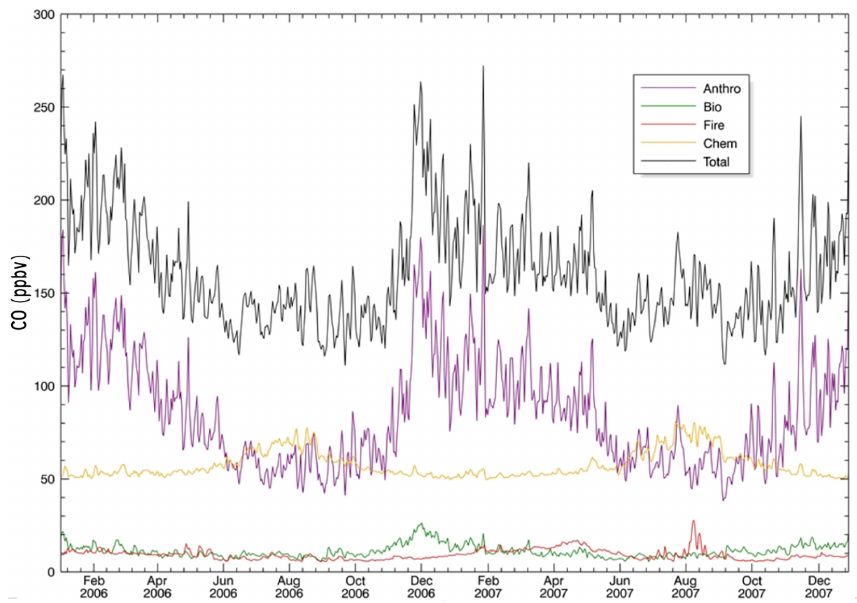
Figure 20. Monthly time series of total surface CO (black) at Sde Boker, Israel, and contributions from specific sources (anthropogenic in purple, chemical production in orange, biogenic in green, and fires in red; ocean is negligible and not shown) as simulated by MOZART for 2006–2007 (adapted from Drori et al.,